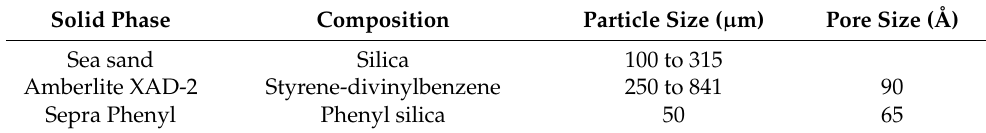
Table 3. Properties of the solid phases used.